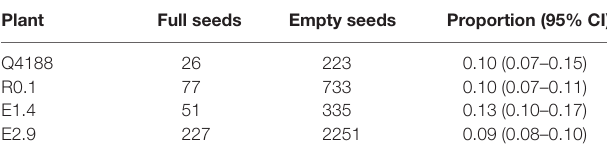
TABle 2 | Proportion of filled caryopses in antisense and control